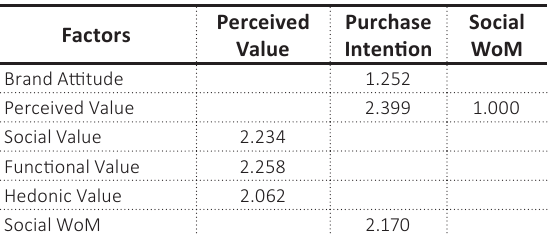
Table 6. Variance inflated factor